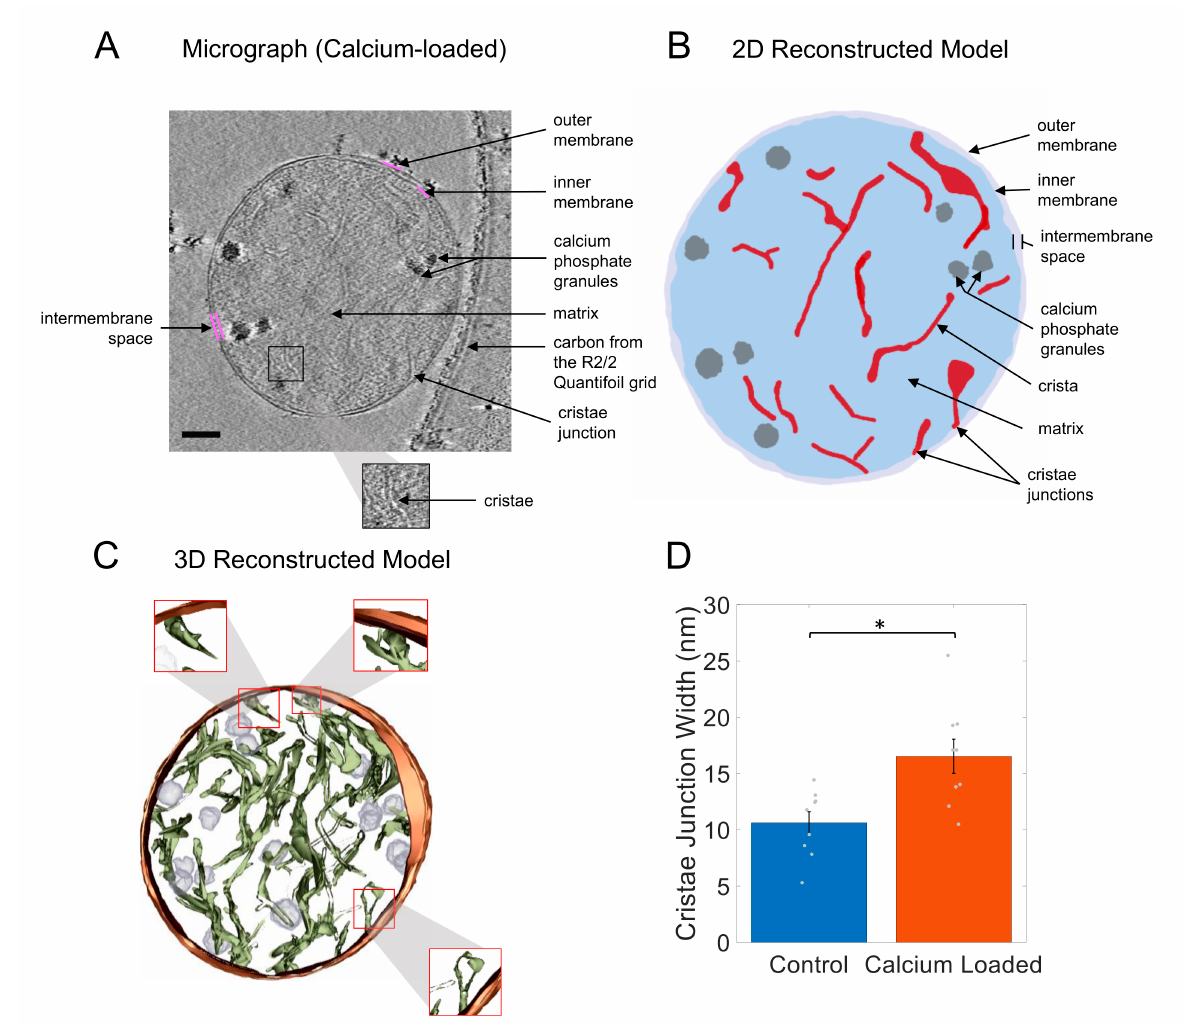
Figure 3. Calcium-loaded mitochondria with granules alters cristae structure. ( A ) Representative portion of a tomogram from a mitochondrion with calcium phosphate granules exposed to a 50 µ M bolus of calcium at an approximate resolution of 4 Å. The solid magenta lines highlight the inner or outer membrane boundaries. ( B ) 2D reconstructed model showing that calcium phosphate granules disrupted the cristae membrane surface area, consisting of most of the enzymes responsible for oxidative phosphorylation. ( C ) 3D reconstructed model showing a densely packed, interconnected cristae network. ( D ) Cristae junction widths in calcium-loaded mitochondria, which were significantly larger than the control widths. Approximately 10 cristae junctions from each type of mitochondrion were selected at random and measured. The bars are plotted as means of the data, with error bars representing the standard error of the mean. A * signifies a p value less than 0.01. Gray dots are individual data points. Scale bar = 250